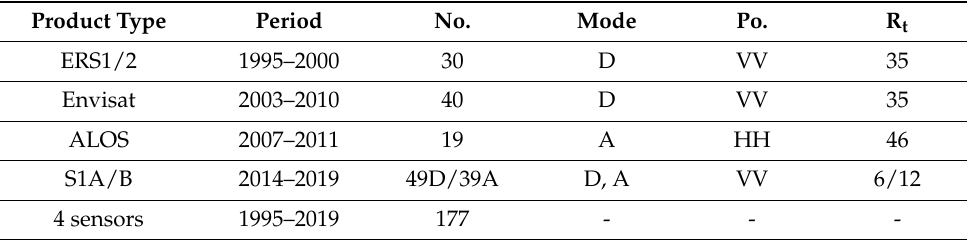
Table 1. Specifications of ERS1/2, Envisat, ALOS, and S1A/B SAR data. Acronyms used in the table are descending (D), number of images (No.), Ascending (A), polarization (Po.), and revisiting time (R t ) in